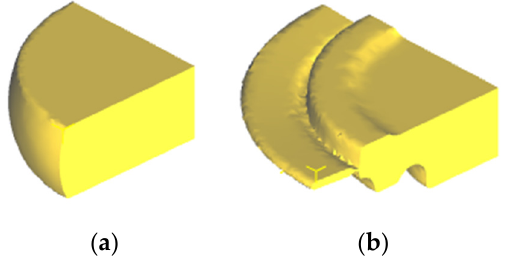
Figure 16. Numerical simulation results. ( a ) Upsetting after billet, ( b ) disk forging.